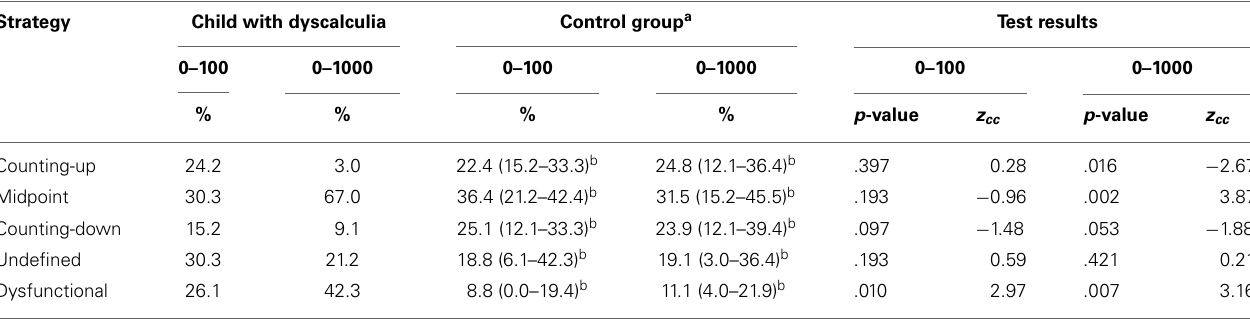
Table 4 | Overview of the estimation strategies used (in percentages) by the child with dyscalculia and the control group (including range